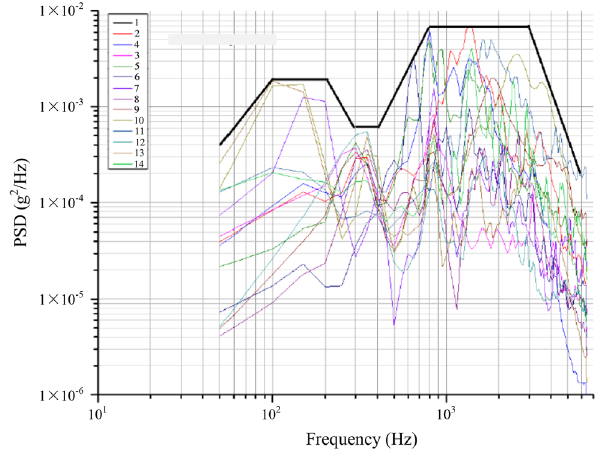
Fig. 5 Standard spectrum of PSD curves at measuring points based on extreme envelope method